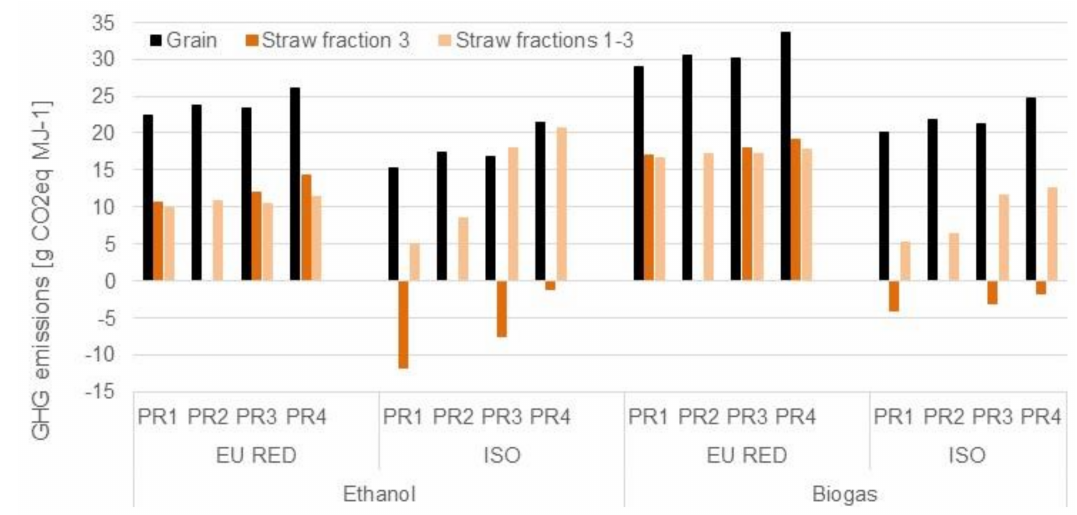
Figure 6. GHG emission impact of regional differences and ratio of straw removal. The outcome using two calculation methods (EU RED and ISO) is compared. PR2 has no available straw in fraction